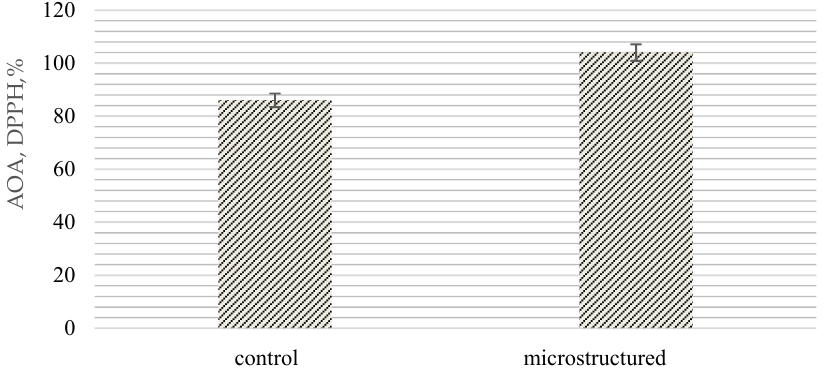
Figure 4. Results of determining the total AOA of the studied solutions of taxifolin, DPPH, %.